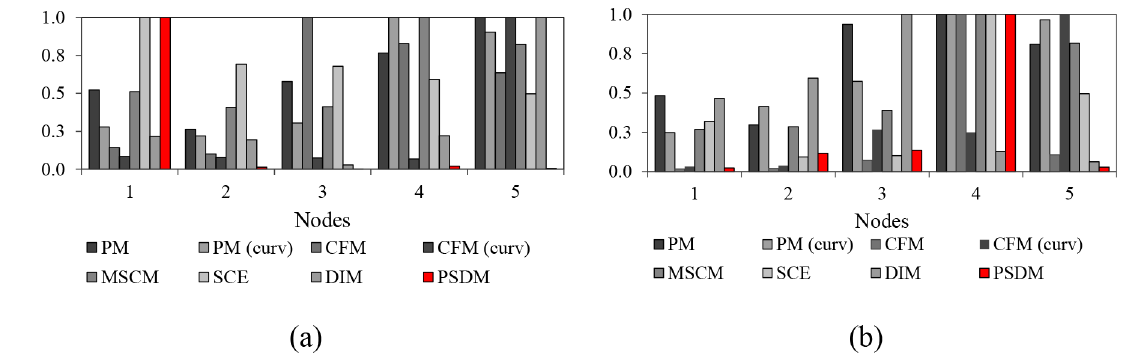
Figure 14. Comparison between all applied damage localisation methods: results in (a) x direction and (b) y